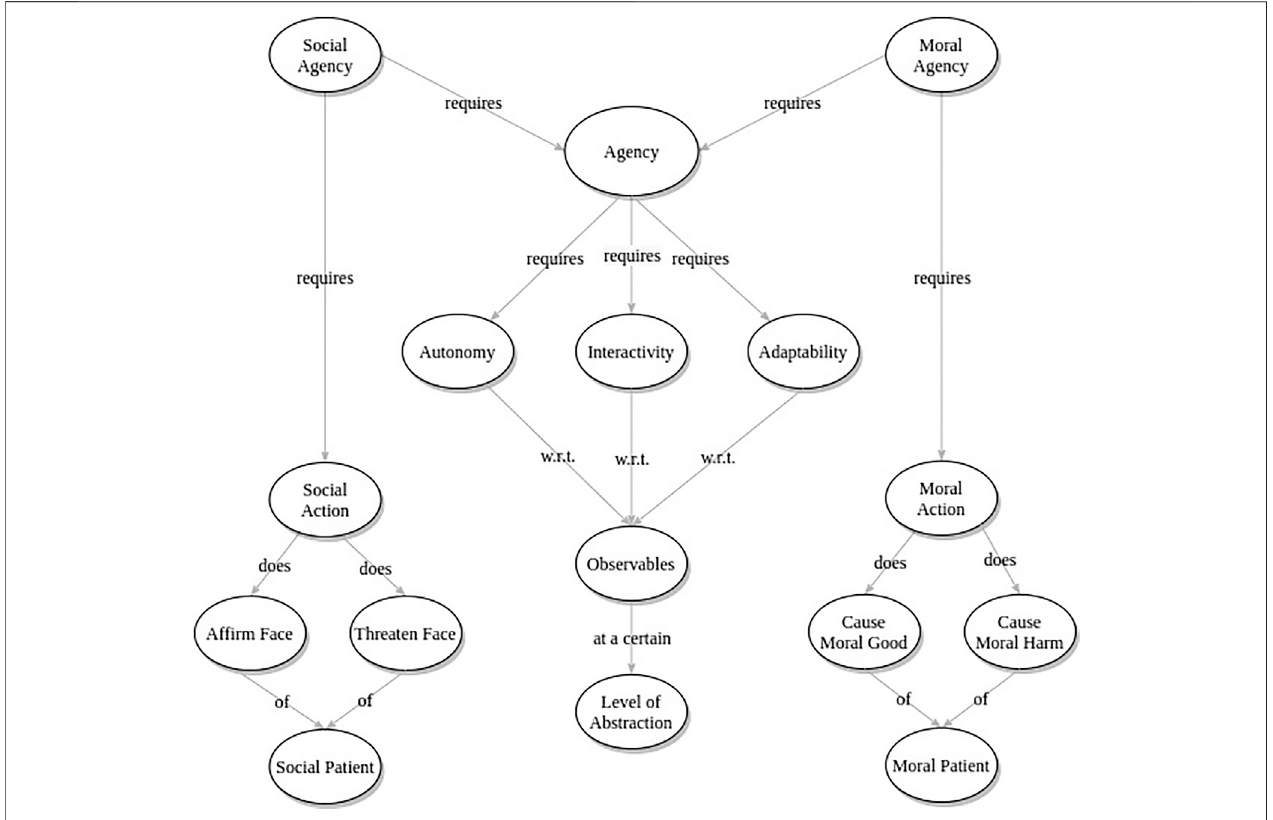
FIGURE 1 | Concept diagram visualizing the theory of Social Agency presented in this paper, and the core concepts combined to construct this theory.